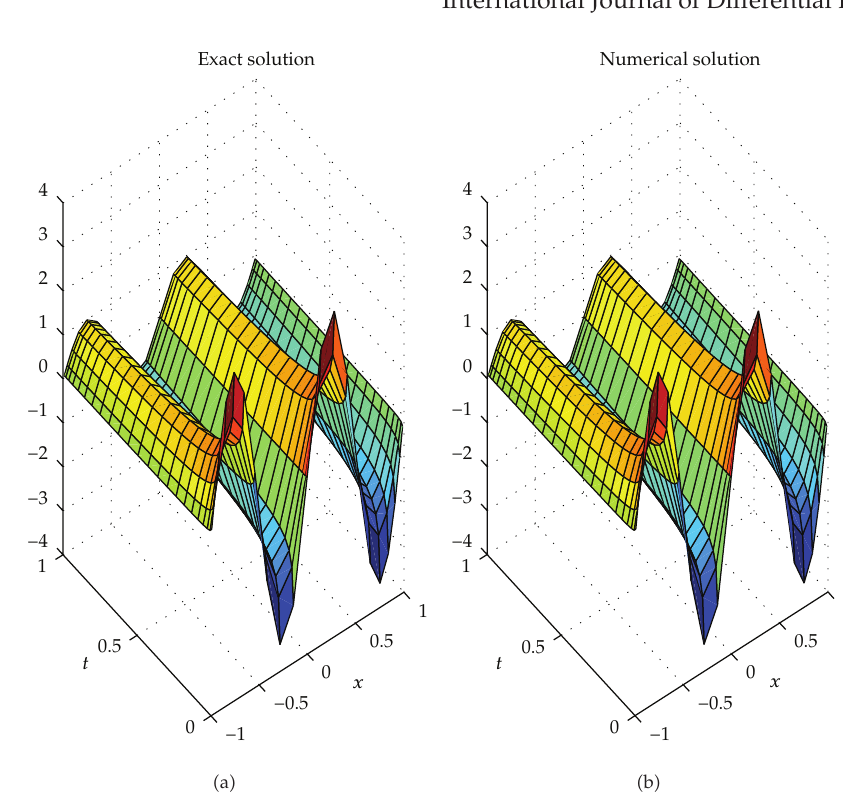
Figure 1: Exact and numerical solution with, μ (cid:6) 0 . 8 ,β (cid:6) − 0 .